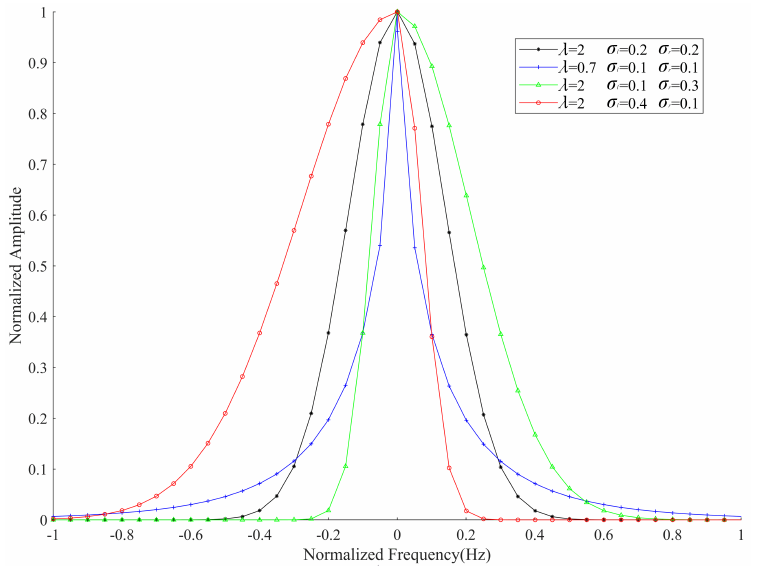
Figure 6. Asymmetric generalized Gaussian curves with different parameter